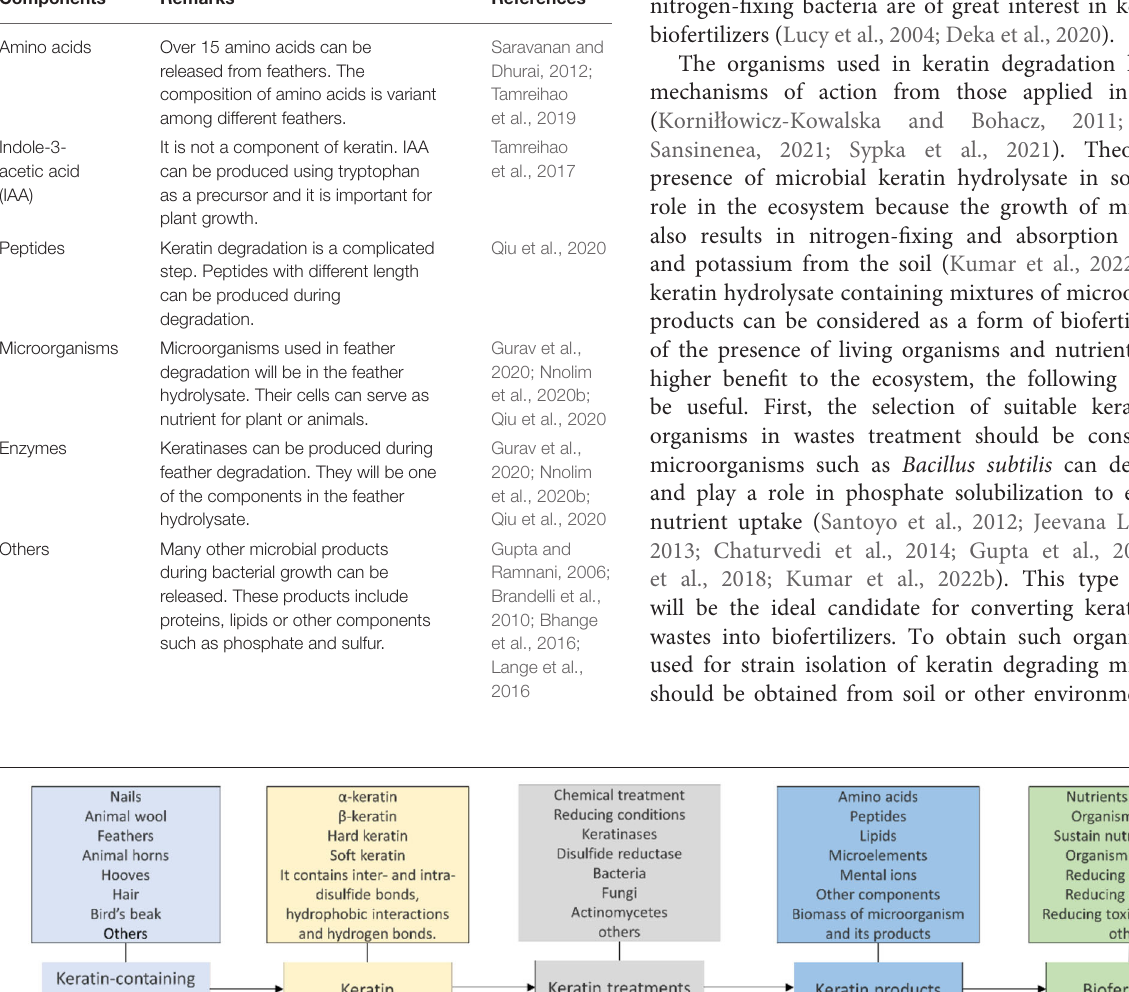
Frontiers in Microbiology |